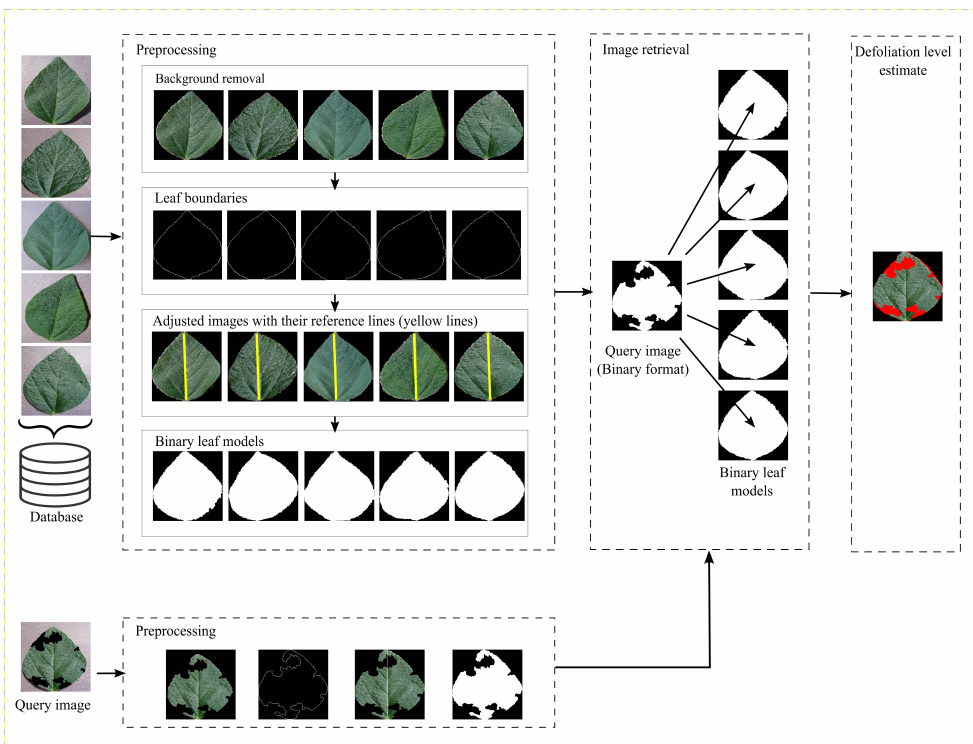
Figure 1. Flowchart of the presented